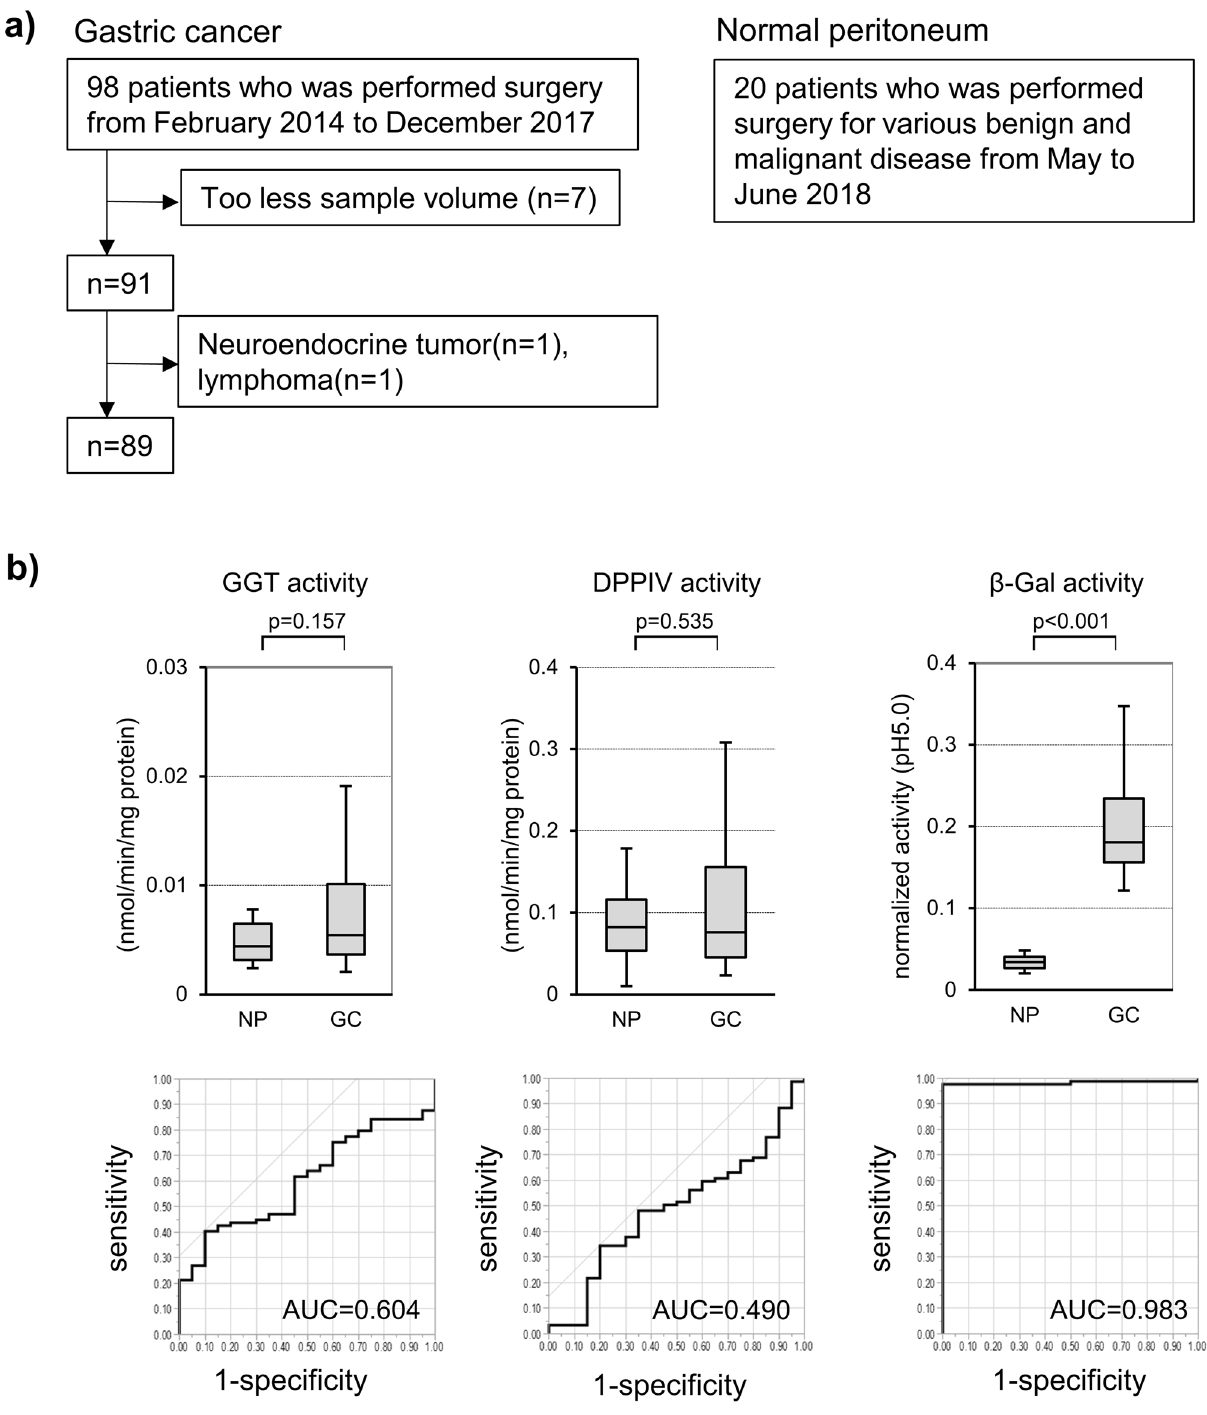
Figure 1. GGT, DPPIV, and β-Gal activity of preserved tumor and NP samples. ( a ) Consort diagram of GC and NP samples used in this study. ( b ) GGT, DPPIV, and β-Gal activity and ROC of NP (n = 20) and GC (n = 89). GGT, gamma-glutamyl transpeptidase; DPPIV, dipeptidyl peptidase IV; β-Gal, β-galactosidase; GC, gastric cancer; NP, normal peritoneum; ROC, receiver operating characteristic curve; AUC, area under the